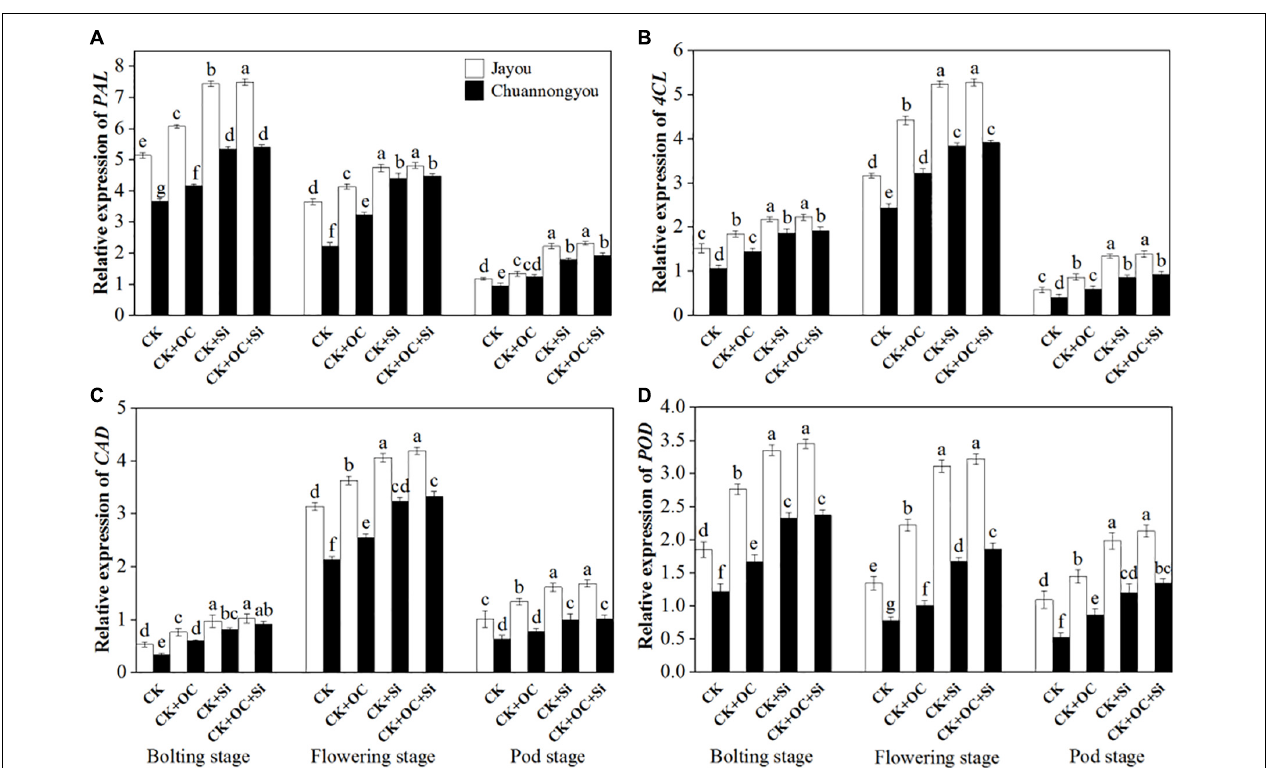
FIGURE 5 | Effect of organic carbon and silicon fertilizers on the expression of genes related to lignin biosynthesis in rapeseed stems (A) PAL, phenylalanine ammonia-lyase activity, (B) 4CL, 4-coumarate: CoA ligase activity, (C) CAD, cinnamyl alcohol dehydrogenase activity, and (D) POD, peroxiredoxins activity. Bars represent mean ± SD ( n = 3). Different lower-case letters indicate significant differences among treatments at p ≤ 0.05 (LSD test). The CK, CK + OC, CK + Si, and CK + OC + Si represent the conventional fertilization, conventional + organic carbon fertilization, conventional + silicon fertilization treatment, and conventional + organic carbon + silicon fertilization